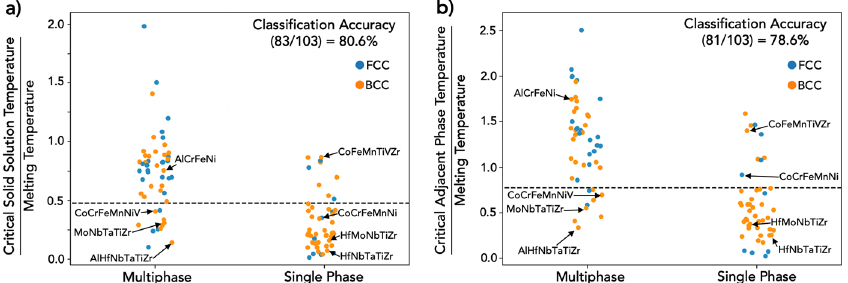
Fig. 6 Critical temperatures of 103 equimolar, as-cast HEAs. a ‘ Critical solid-solution ’ temperature of each HEA divided by the highest melting temperature of the pure elements in the HEA system. b ‘ Critical adjacent phase ’ temperature of each HEA divided by the highest melting temperature of the pure elements in the HEA system. Only FCC and BCC phases are considered, as the regular solution parameters in 33 are for FCC and BCC phases. Cutoff values of 0.48 and 0.78 were chosen in ( a, b ), respectively, as these cutoff values result in the highest fraction of alloys being correctly classi fi ed as single or multiphase, 80.6 and 78.6%, respectively. A different choice of cutoff values would result in lower classi fi cation accuracies. Values for AlCrFeNi, CoCrFeMnNi, HfMoNbTiZr, HfNbTaTiZr, MoNbTaTiZr, AlHfNbTaTiZr, CoFeMnTiVZr, and CoCrFeMnNiV are labeled with arrows. The critical temperatures of all 103 HEAs shown can be found in Supplementary Data